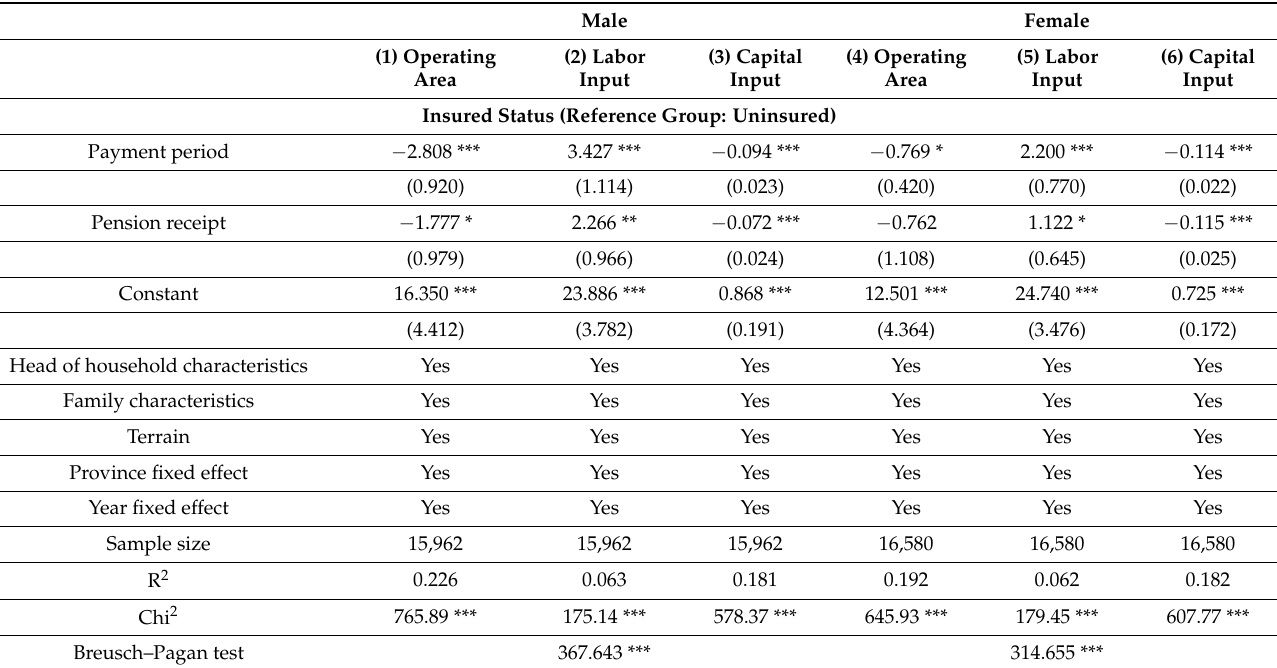
Table 6. Estimation results for NRPS under gender